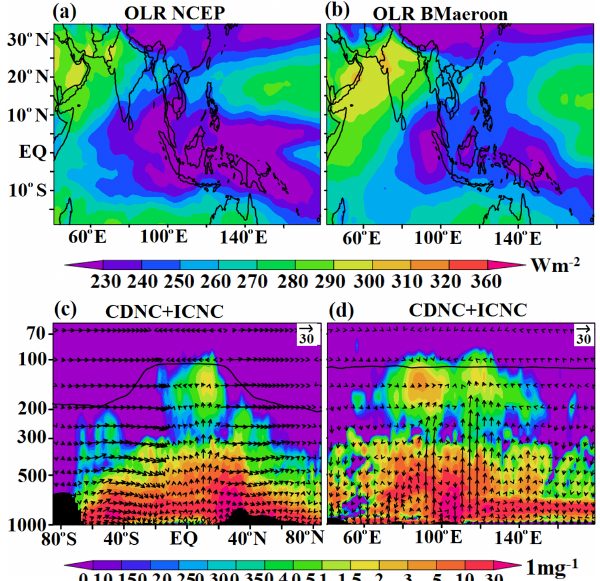
Figure 5. (a) Distribution of outgoing longwave radiation (OLR) (Wm − 2 ) from NCEP Reanalysis-2 data averaged for spring 2013, (b) same as (a) but from the ECHAM6–HAMMOZ simulations (BMaeroon). Vertical distribution of cloud droplet number con- centration (CDNC) and ice crystal number concentration (ICNC) (1mg − 1 ) averaged for spring 2013 from ECHAM6–HAMMOZ simulations (BMaeroon), and (c) latitude–pressure section (average for 85–140 ◦ E) and (d) longitude–pressure section (average for 10– 20 ◦ N). Vectors of the circulation (BMaeroon) are shown in (c) – (d) , with the vertical velocity field scaled by